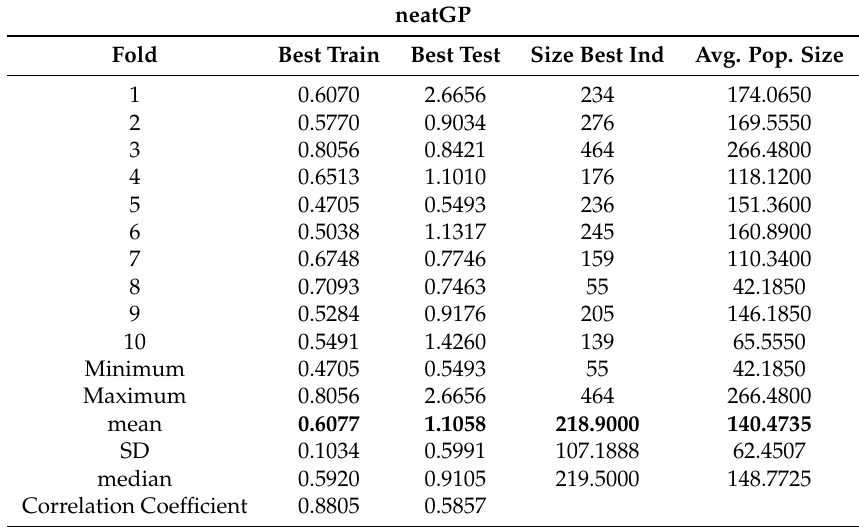
Table 7. RMSE for the 10-fold cross validation performance of neatGP on the 1–4 scale dataset.